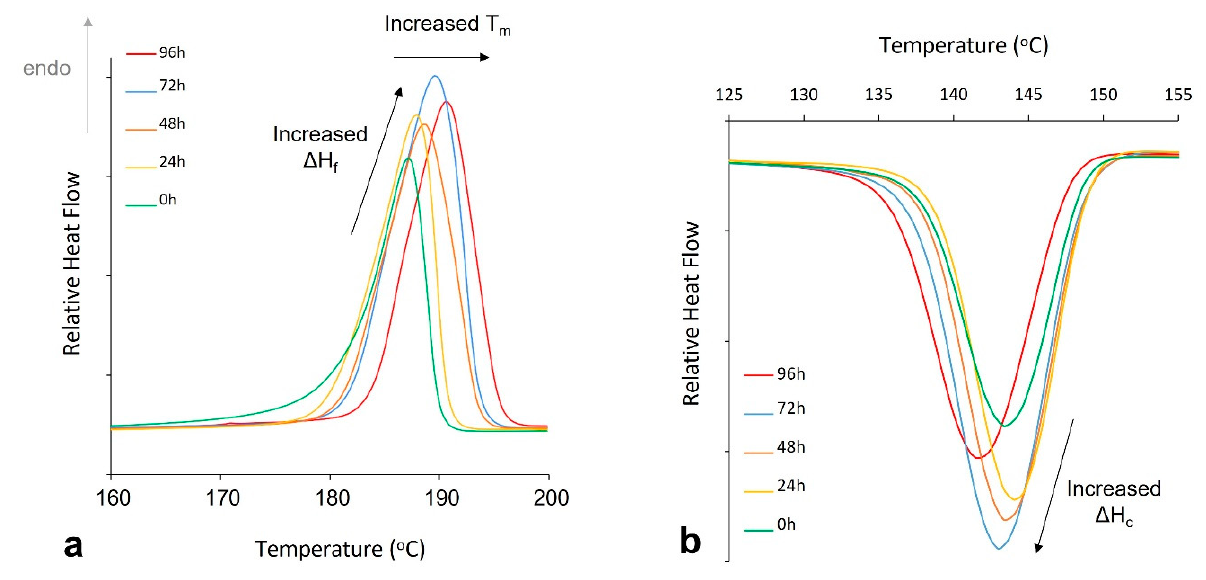
Figure 4. DSC first heat–cool showing the change in ( a ) melting behaviour and ( b ) crystallisation behaviour, for the first 100 h of oven storage.